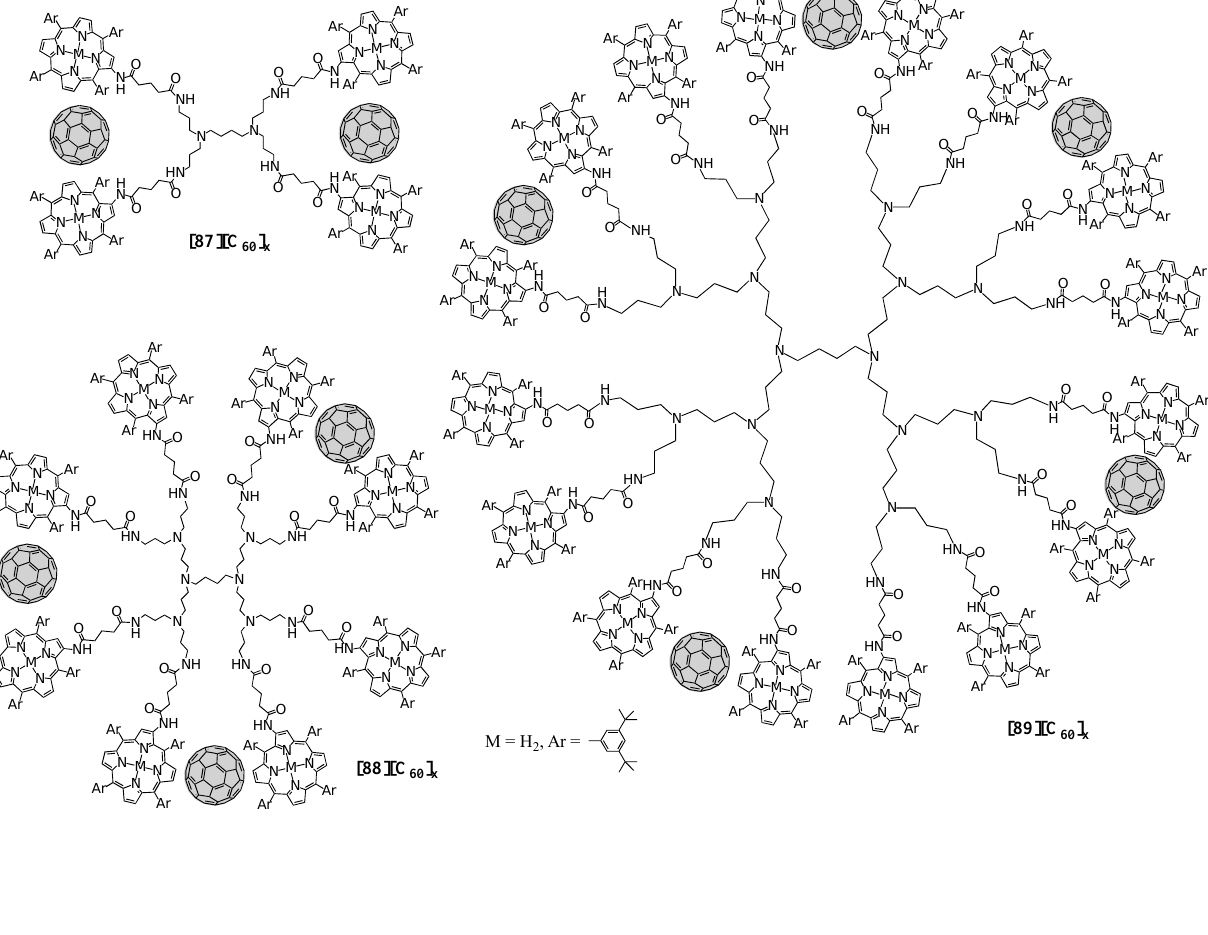
with first to third generation POPAM 60